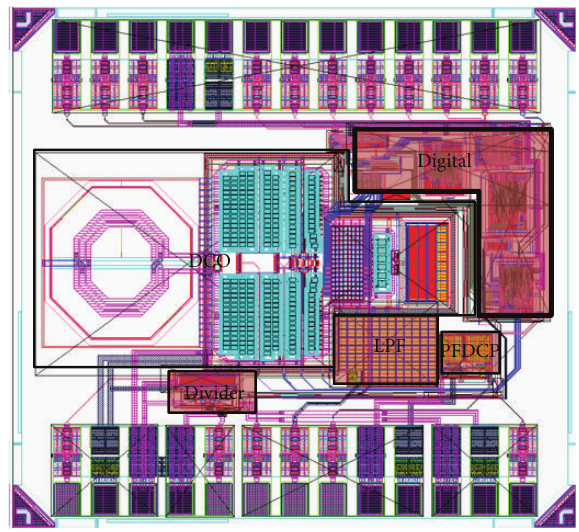
Figure 15: SDPLL layout in 65 nm CMOS (active area: 0.52 mm 2